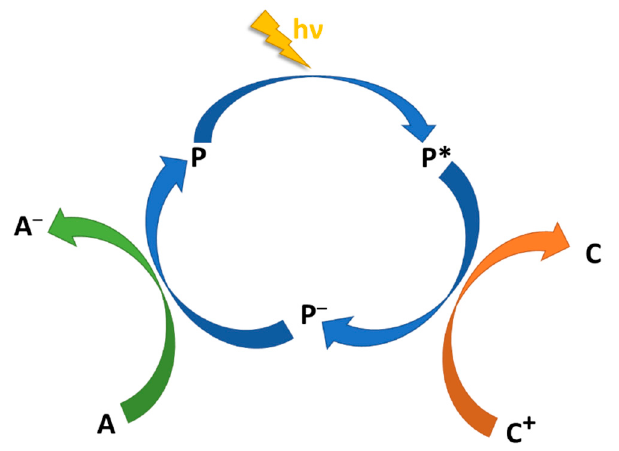
Figure 12. “Anti-biomimetic” scheme for catalyst oxidation performed by the Ru4/RuPOM system: reductive quenching of excited photosensitizer (P) by catalyst (C), followed by electron transfer to sacrificial acceptor (A)